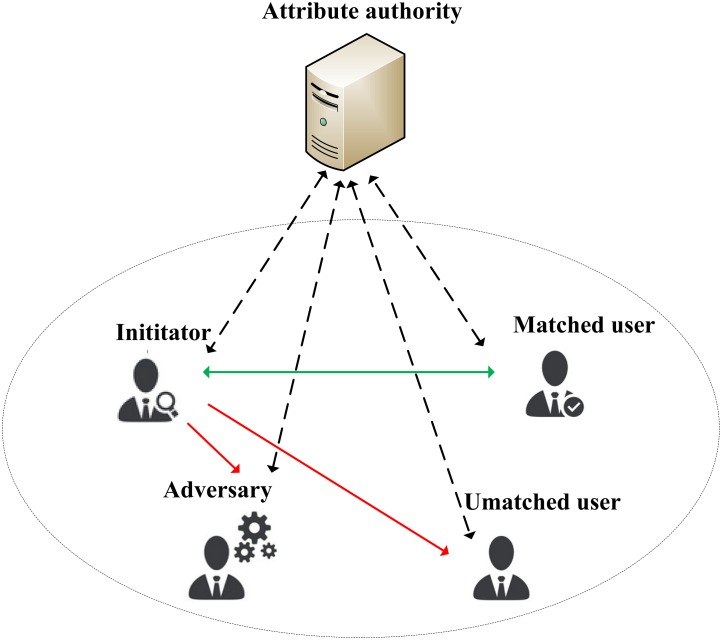
Our System Model.